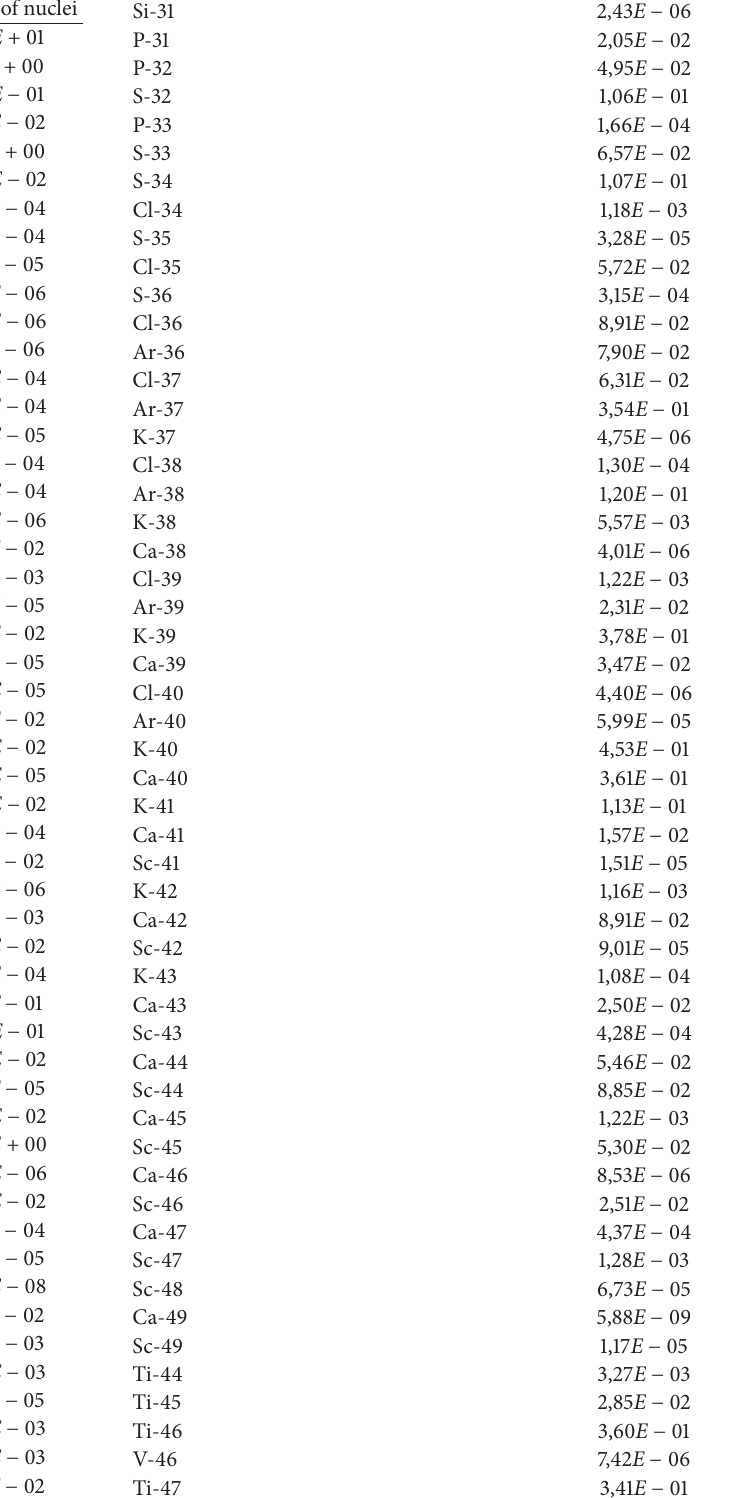
Table 2: Isotope distribution after interactions between CR and Kaidun